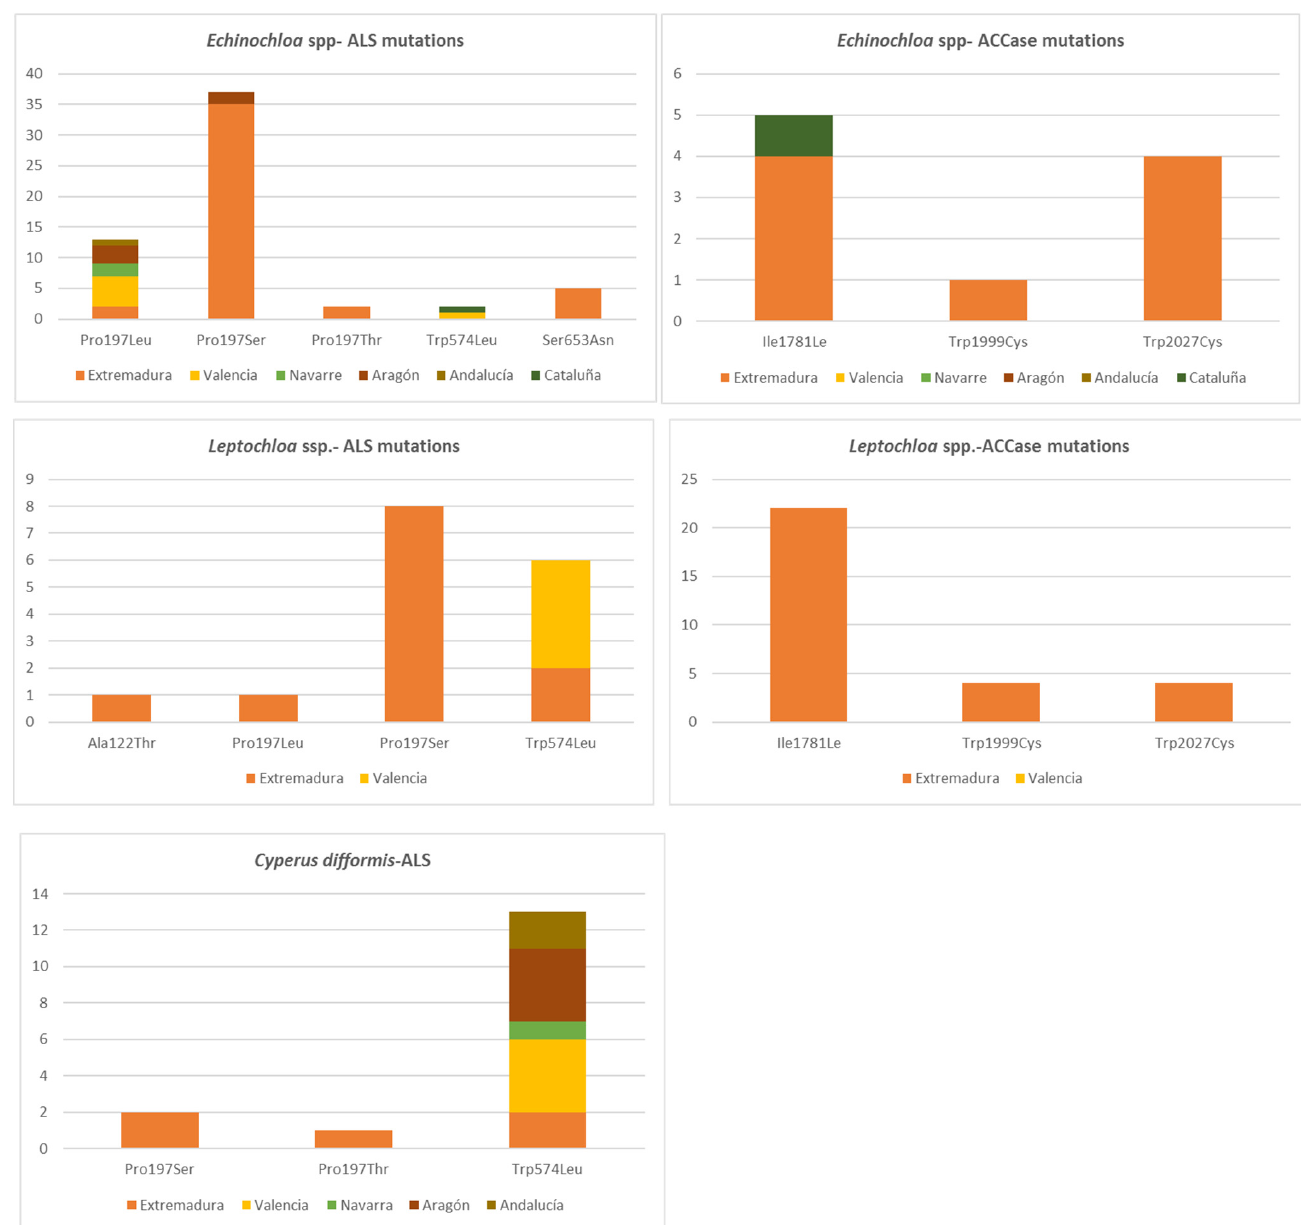
Figure 3. Different mutations in ALS and ACCase genes in individuals of Echinochloa spp., Leptochloa spp., and Cyperus difformis collected from different rice-growing areas of